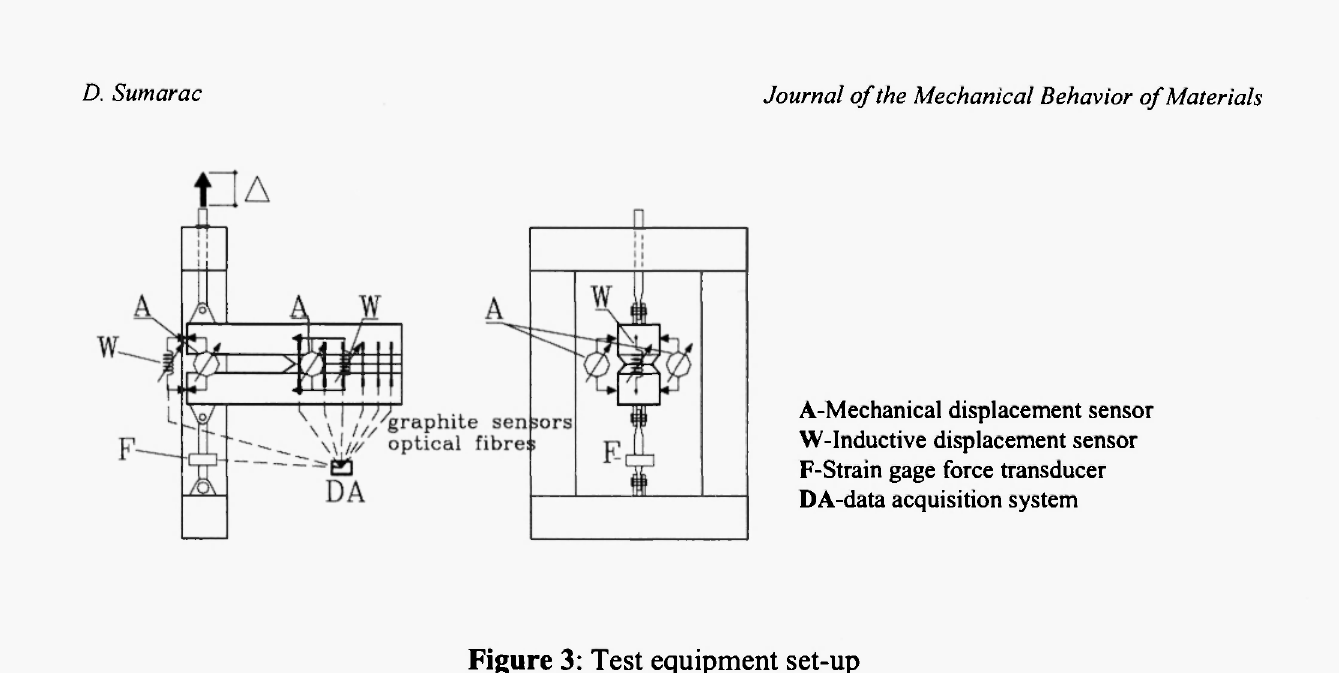
Figure 3: Test equipment set-up